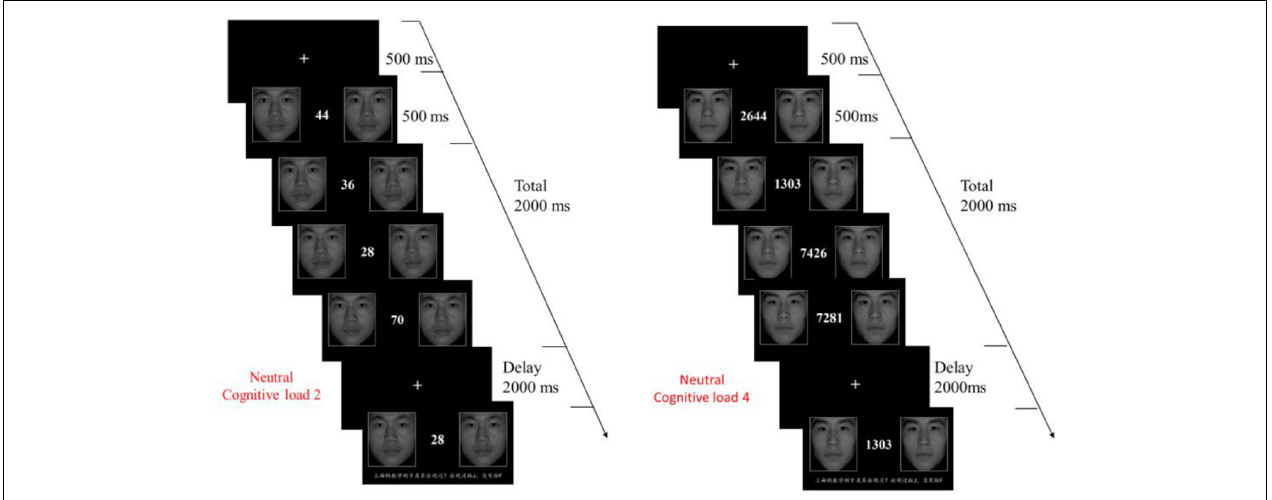
FIGURE 1 | Emotional delay-match-to-sample task design. There were four groups of numbers displayed one after another, all of them cost 2,000 ms to finish. After that, a white fixation cross appeared again lasts for 2,000 ms, and then there were pictures with “numbers” in the center and EFs on both sides. The participants needed to judge whether the number had appeared in the previous four sets of numbers.